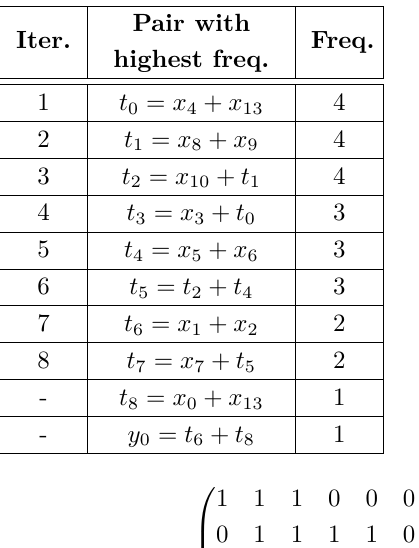
Table 1: Computation sequence when applying Paar1 algorithm to matrix M . x i refers to the input signals ∀ i ∈ { 0 , ..., 13 } , y j refers to the targets ∀ j ∈ { 0 , ..., 6 } and t k refers to the temporary intermediate gates ∀ k ∈ N